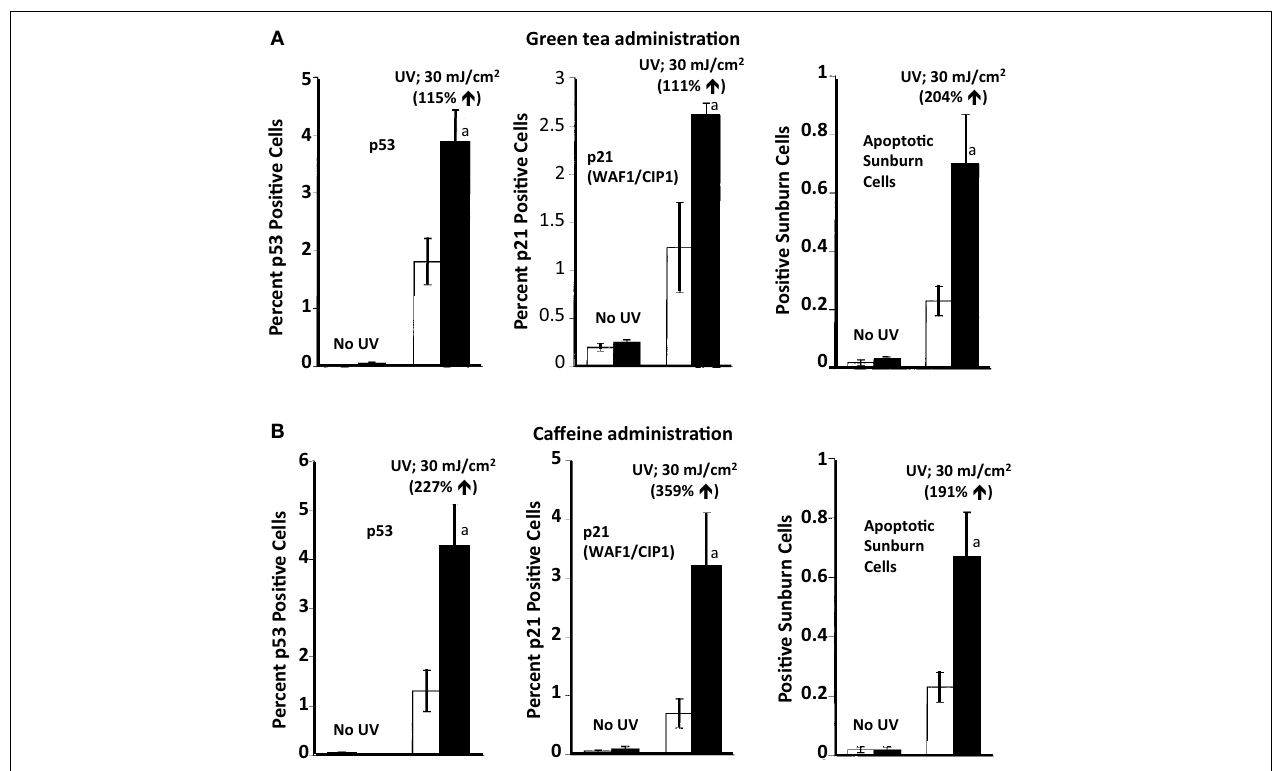
SKH-1 mice were treated with water ( (cid:3) ) or caffeine (0.44mg/ml; (cid:4) ) as their sole source of drinking fluid for 2weeks.The mice were then treated with UVB (30mJ/cm 2 ) and were killed 10h later. In (A,B) , each value represents the mean ± SE from five mice; a P < 0.05. Stimulatory effect of green tea or caffeine was shown as % increase by comparing with “water + UVB.”Taken from Lu et al. (2000).